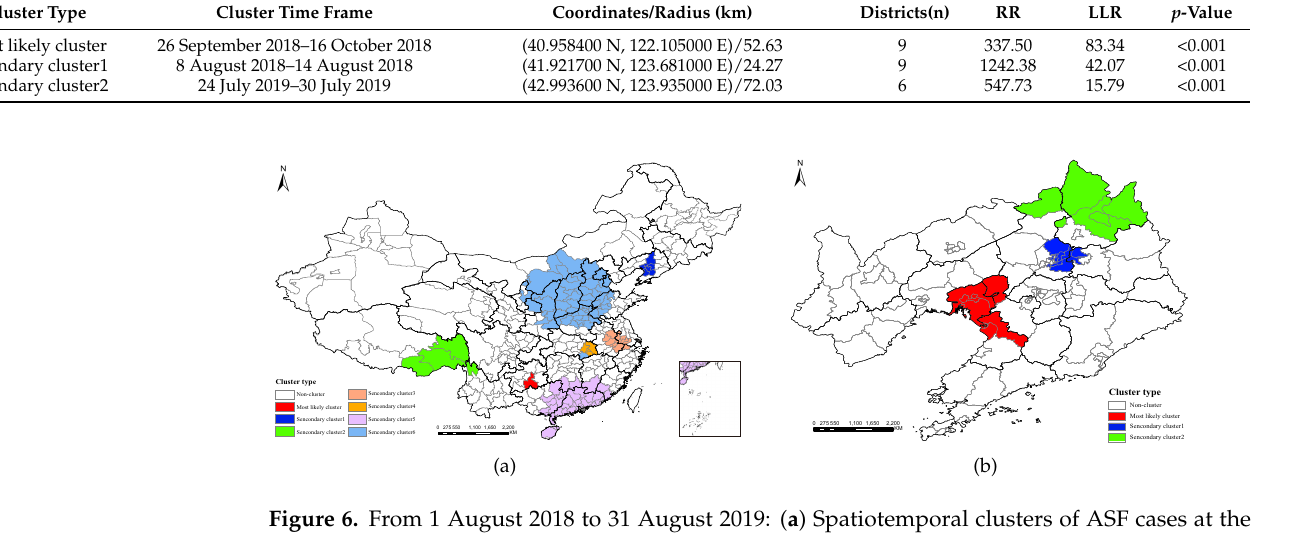
Figure 6. From 1 August 2018 to 31 August 2019: ( a ) Spatiotemporal clusters of ASF cases at the city level in Mainland China. ( b ) Spatiotemporal clusters of ASF at the district or county level in Liaoning